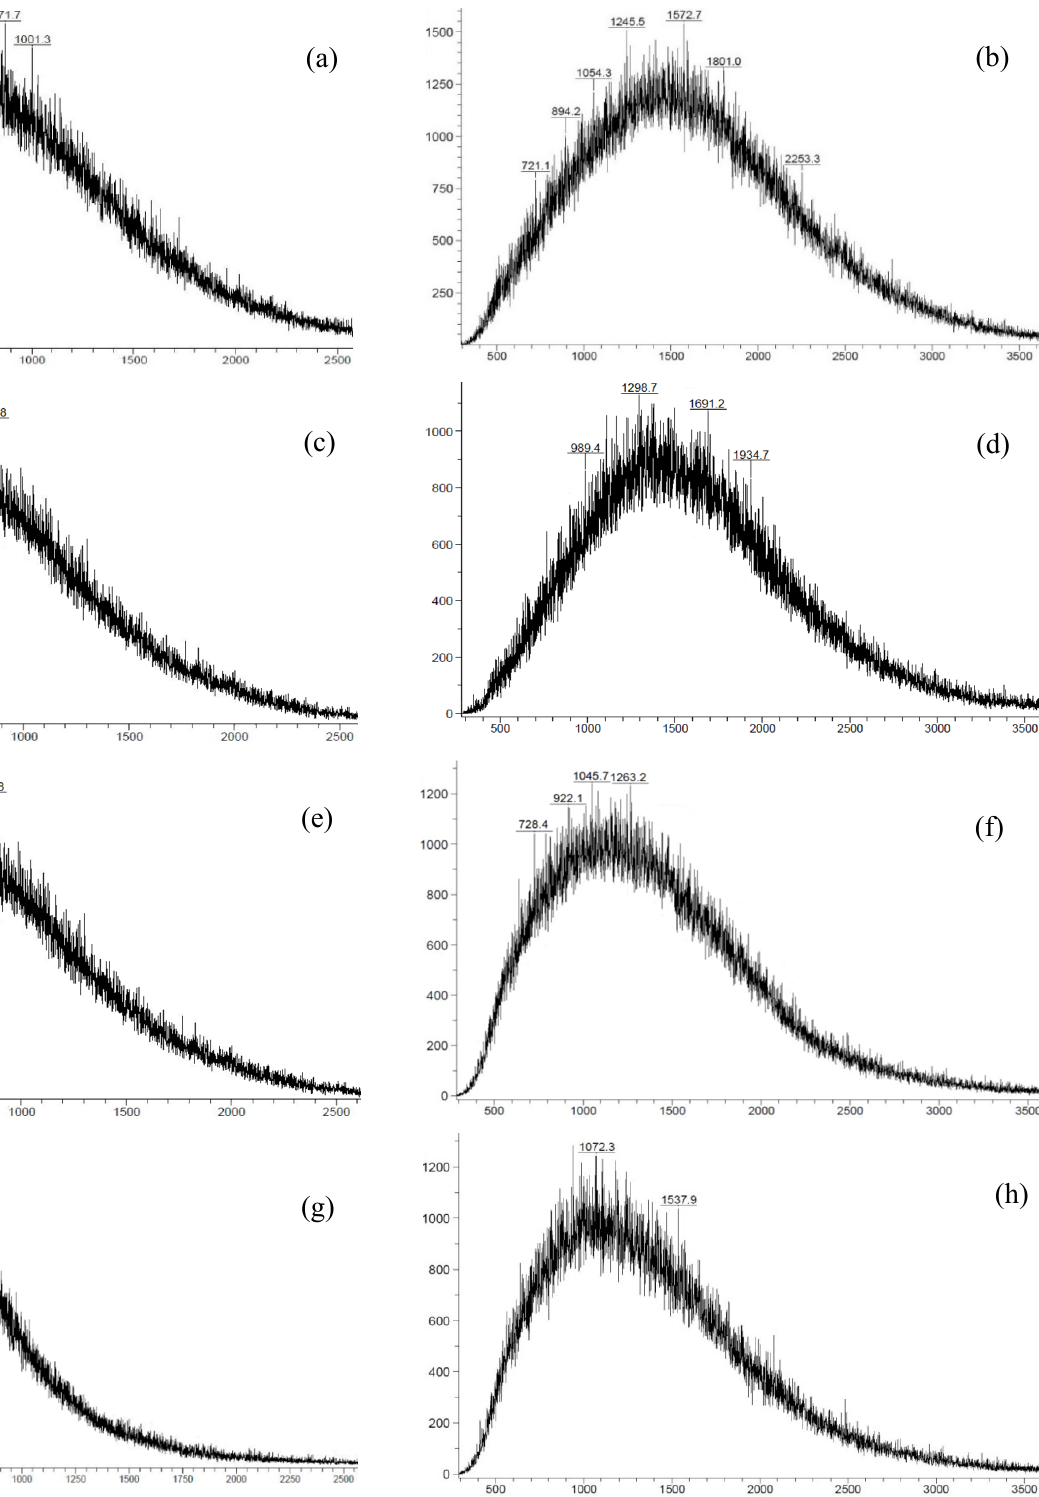
Figure 9. Matrix-activated laser desorption/ionization (MALDI) spectra of resins ( a , c , e , g ) and asphaltenes ( b , d , f , h ) before ( a , b ) and after catalytic upgrading for 48 h ( c , d ), 72 h ( e , f ), and 96 h ( g , h ).